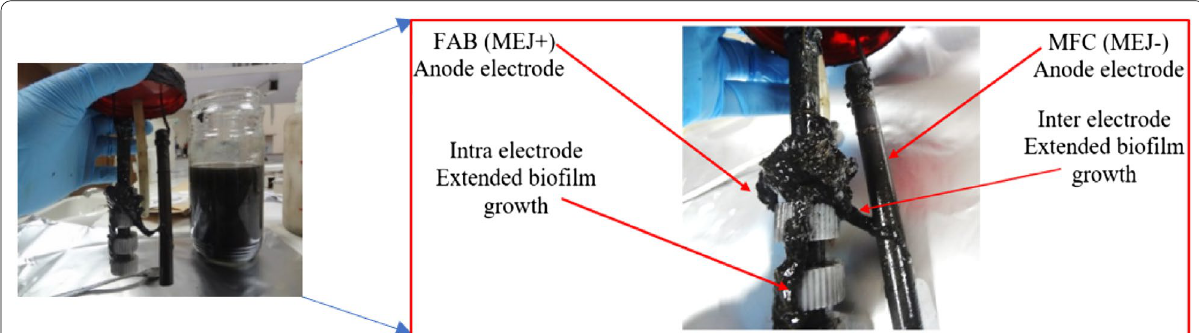
Fig. 7 Biofilm growth and development in bench-scale FAB-MFC setup. The biofilm extended in between the FAB (MEJ electrode inserted in the same